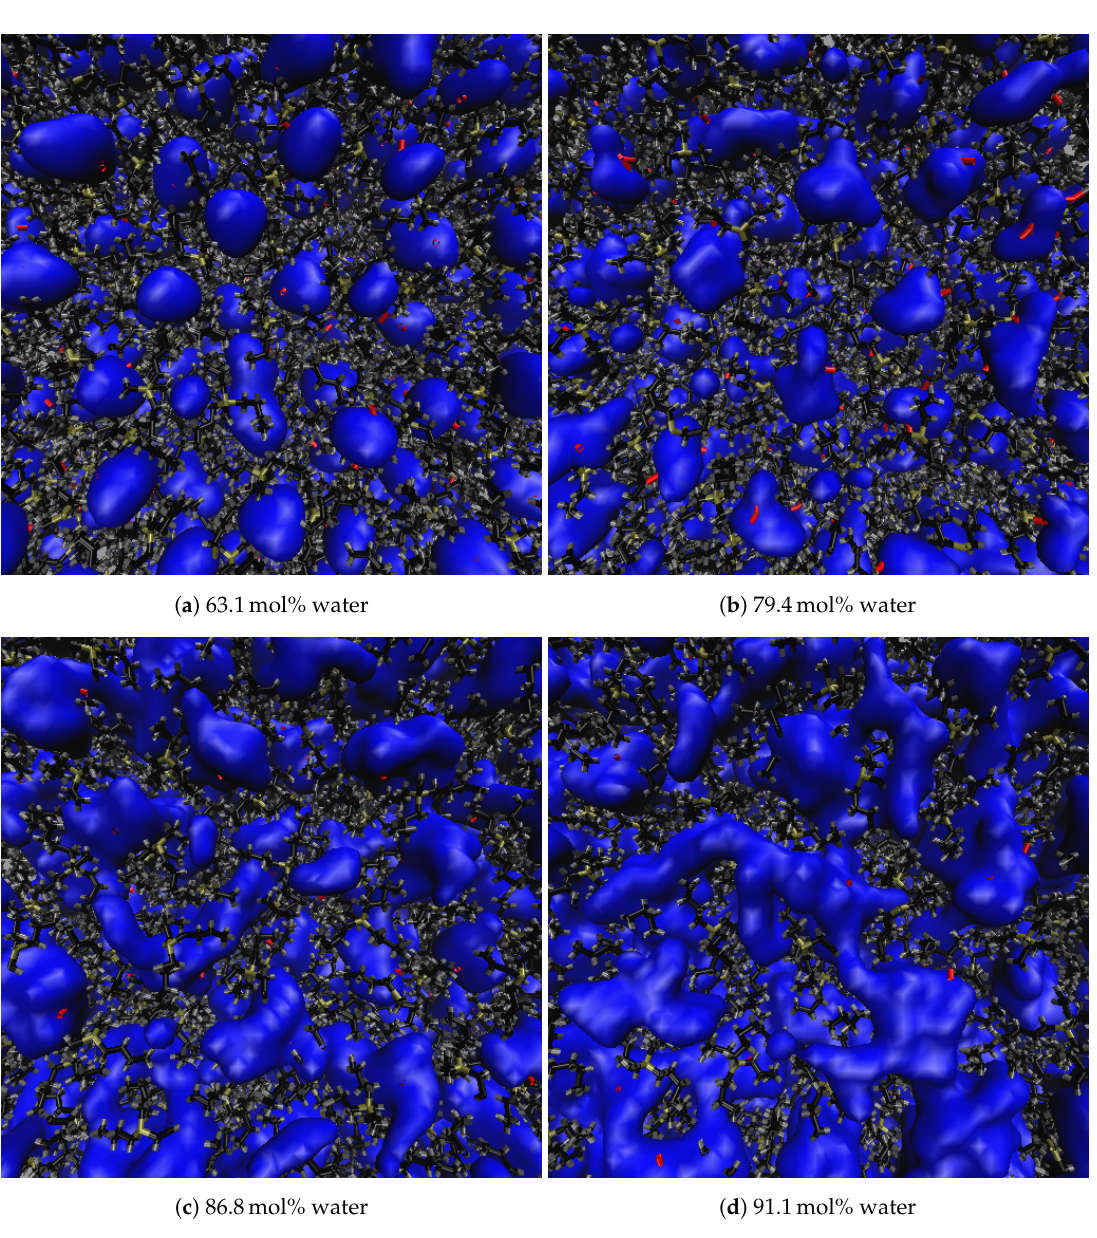
Figure 9. Water veins and channeling in TBPH at 320K (Part 1 of 2) [27,28]. The Figures represent the changing water structure with increasing water concentration: ( a ) 63.1mol% water; ( b ) 79.4mol% water; ( c ) 86.8mol% water; ( d ) 91.1mol% water. The blue-colored water is represented using an isosurface drawing method (called quicksurf in VMD [13]), which uses a volumetric Gaussian density map of the water to produce the observable surface. The TBP and OH molecules are represented using the dynamic bonds drawing method in VMD [13]. TBP is colored tan, black and gray, for the phosphorus, carbon, and hydrogen atoms, respectively. The hydroxide is colored in red for both the oxygen and hydrogen